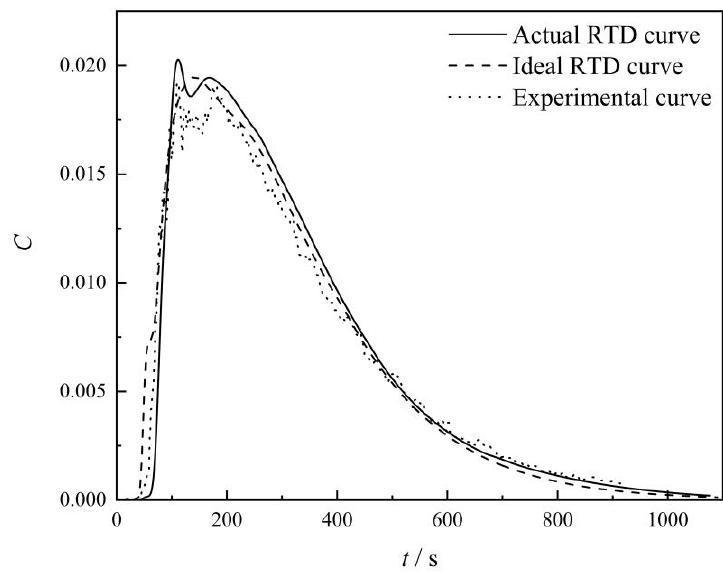
Figure 5. RTD curve results of numerical simulation and water model.